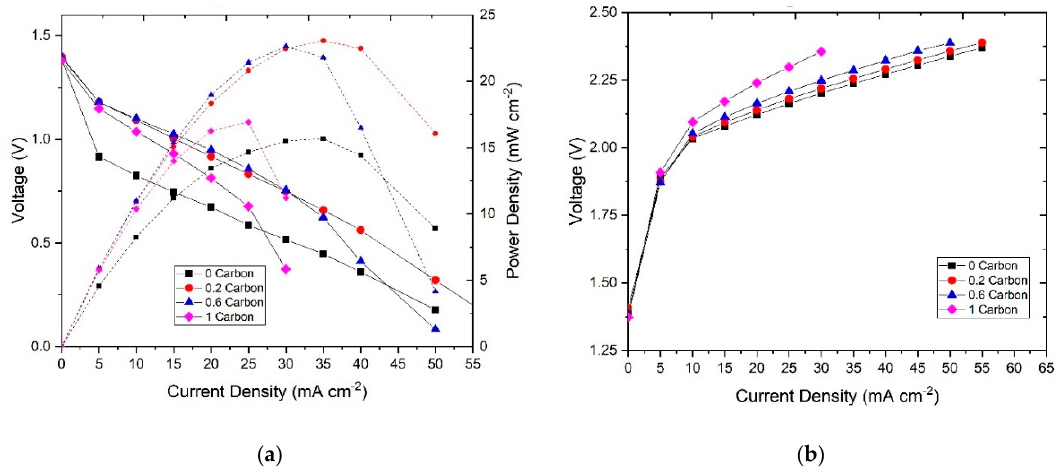
Figure 5. ( a ) Discharge polarization curves with their power densities and ( b ) charge polarization of the zinc slurries with different carbon contents.